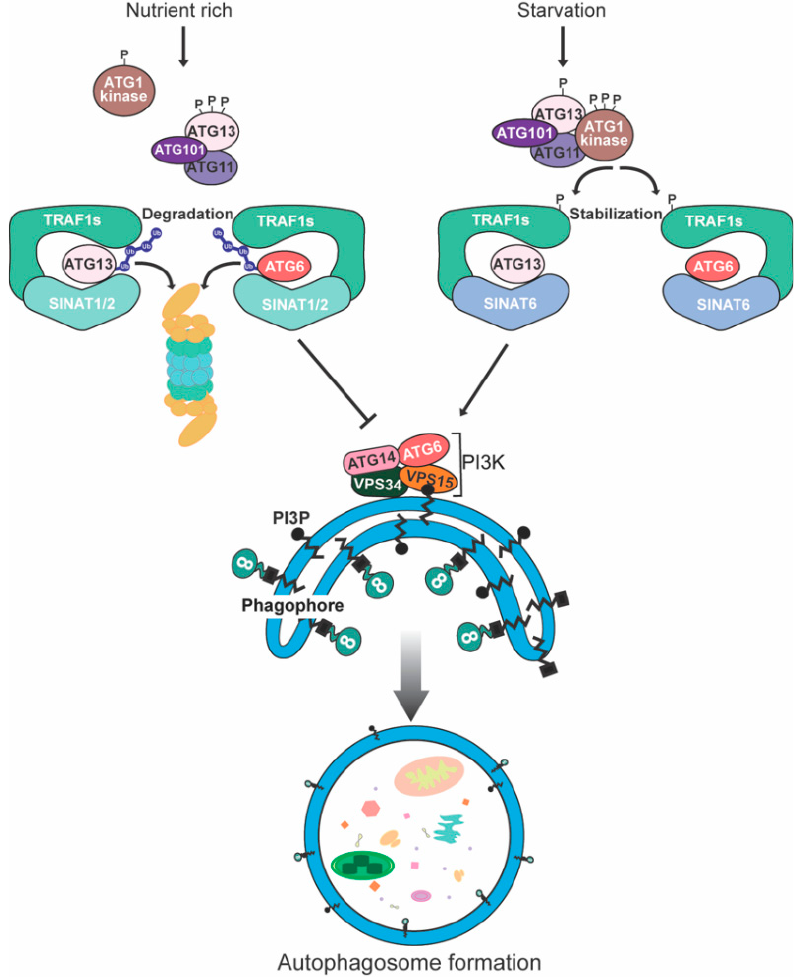
Figure 3. Degradation mechanisms of ATG6 and ATG13 in plants. During nutrient-rich conditions, the TRAF1s-SINAT1/SINAT2-ATG6 and TRAF1s-SINAT1/SINAT2-ATG13 TRAFasomes regulate the ubiquitination and proteasomal degradation of ATG6 and ATG13, which results in inhibiting autophagy. Under the condition of nutrient starvation, SINAT6 accumulates to form the TRAF1s-SINAT6-ATG6 and TRAF1s-SINAT6-ATG13 TRAFasomes, which maintain the stability of ATG6 and ATG13. Furthermore, ATG1 kinase phosphorylates TRAF1s to increase its